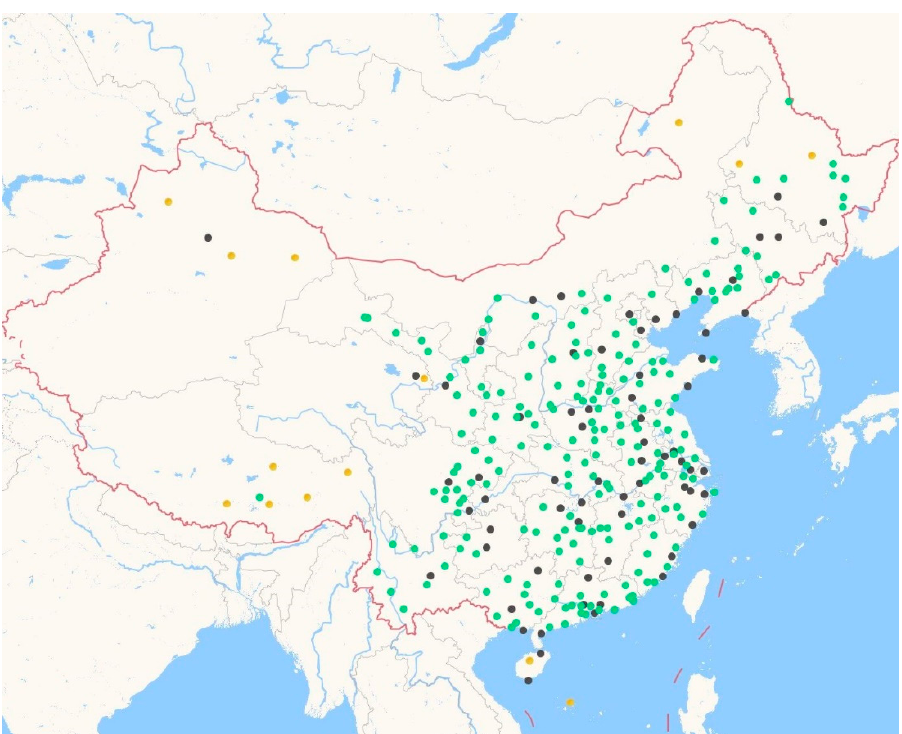
Figure 2. The map of the cities covered by sample studies (notes: Yellow dots refer to cities covered by less than 4 studies; green dots denote cities explored by 4 to 6 studies; black dots are cities investigated by more than 6 studies.).